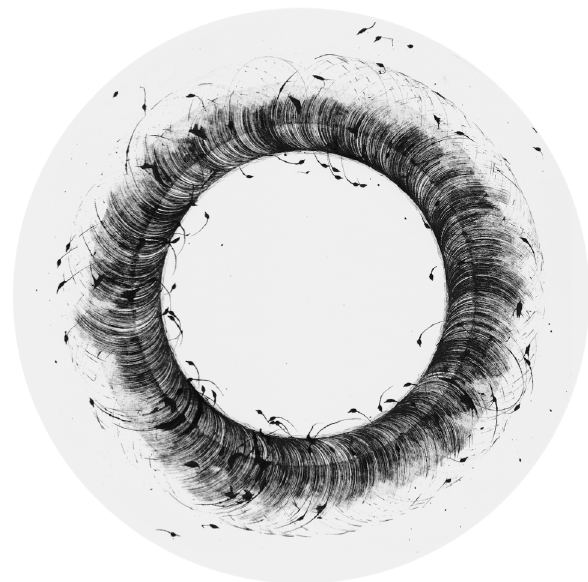
Figure 5 | The Mixer. Drawing machine.